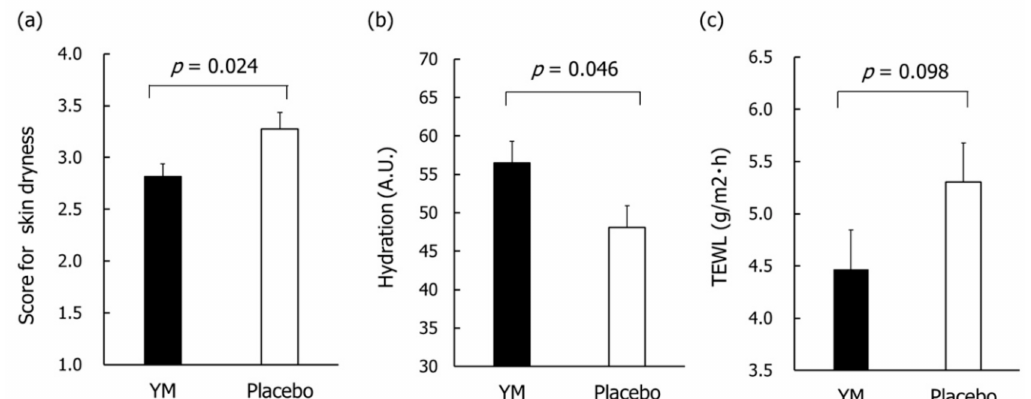
Figure 5. E ff ects of YM intake on skin conditions after 8 weeks of intervention. Data represent the means ± SE. Questionnaire of skin dryness ( a ). The p- value was estimated using the Mann–Whitney U test. Cheek hydration ( b ), and inner forearm TEWL ( c ) in the subjects with dry-skin type. A.U.: arbitrary unit. TEWL: transepidermal water loss. The p- values were calculated using unpaired samples Student’s t -test between YM and placebo